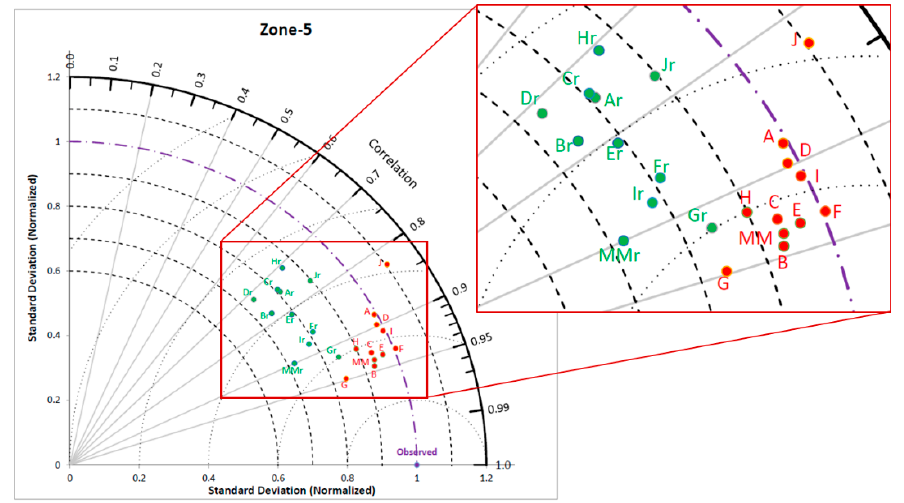
Figure 12. Taylor diagram for downscaling with Re-Obs and GCM-Obs models for zone 5. Notations are same as used in Figure 8.